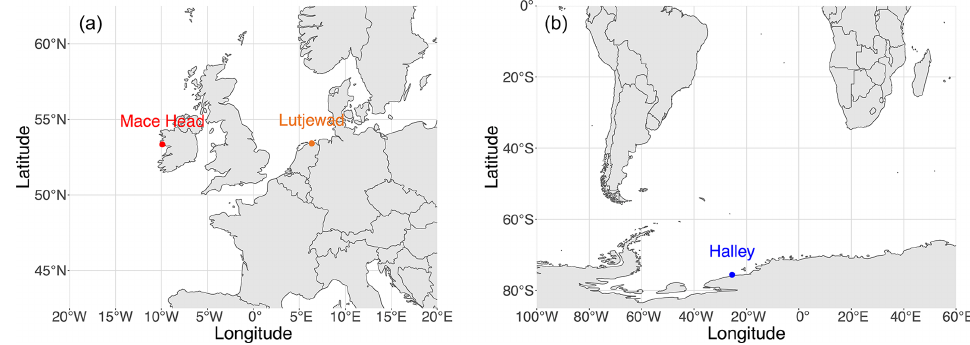
Figure 1. (a) Locations of the Mace Head (red) and Lutjewad (orange) stations. (b) Location of Halley station